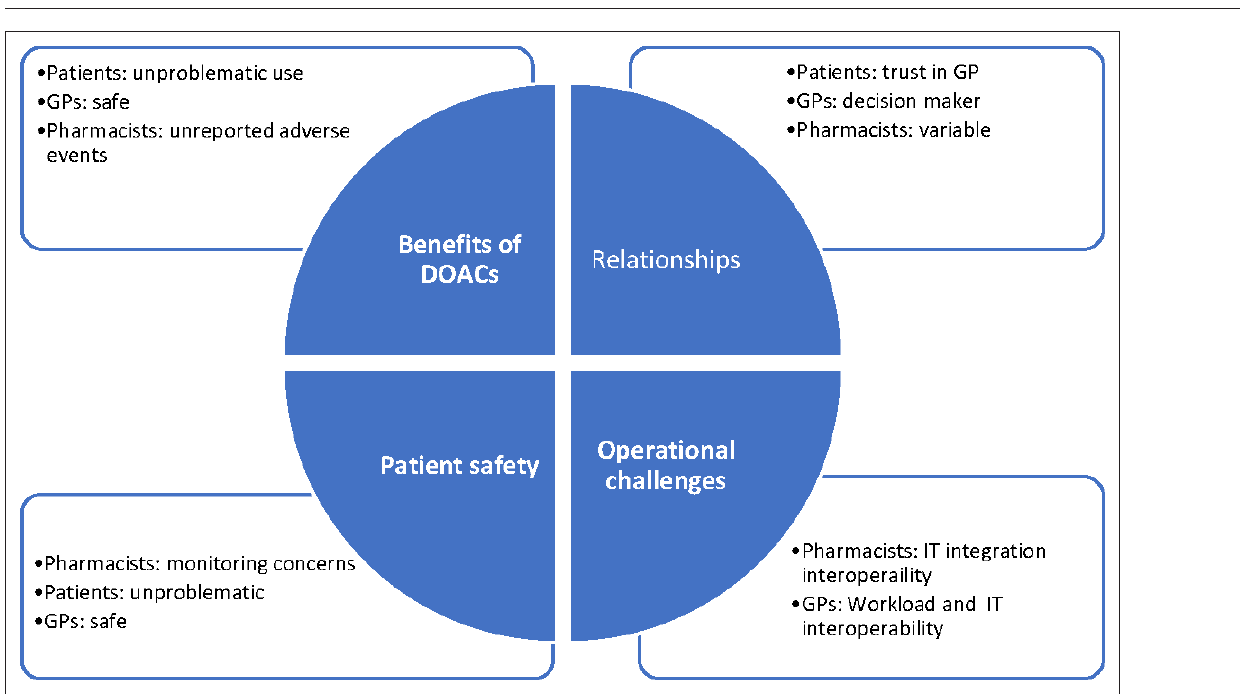
Figure 1 The four integrated themes and how these link to the participant groups. DOAC = direct oral anticoagulant. IT = information